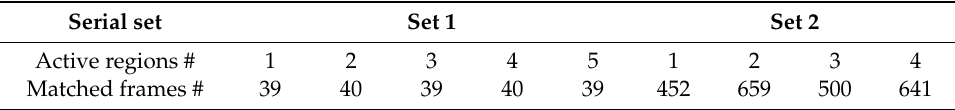
Table 1. Tracing and matching active regions in the time series.